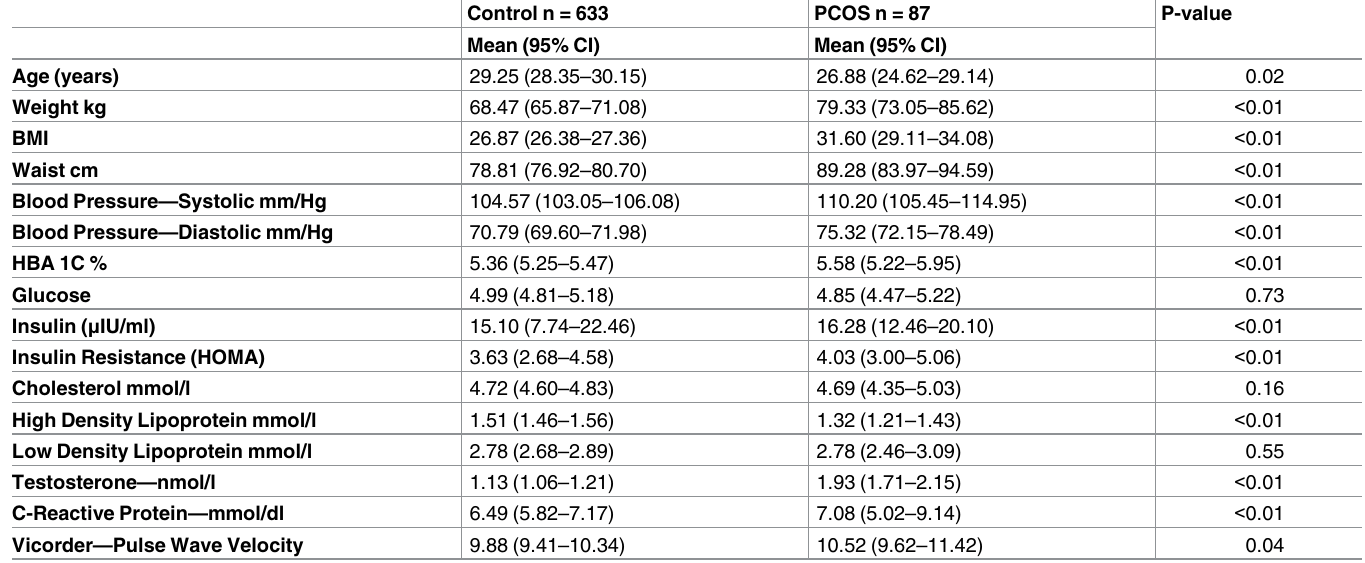
Table 1. Demographic details for 720 women between the ages of 18 to 40 years, comparing normal subjects with women defined as having poly- cystic ovary syndrome by NIH criteria (free androgen index greater than 4.5, with irregular